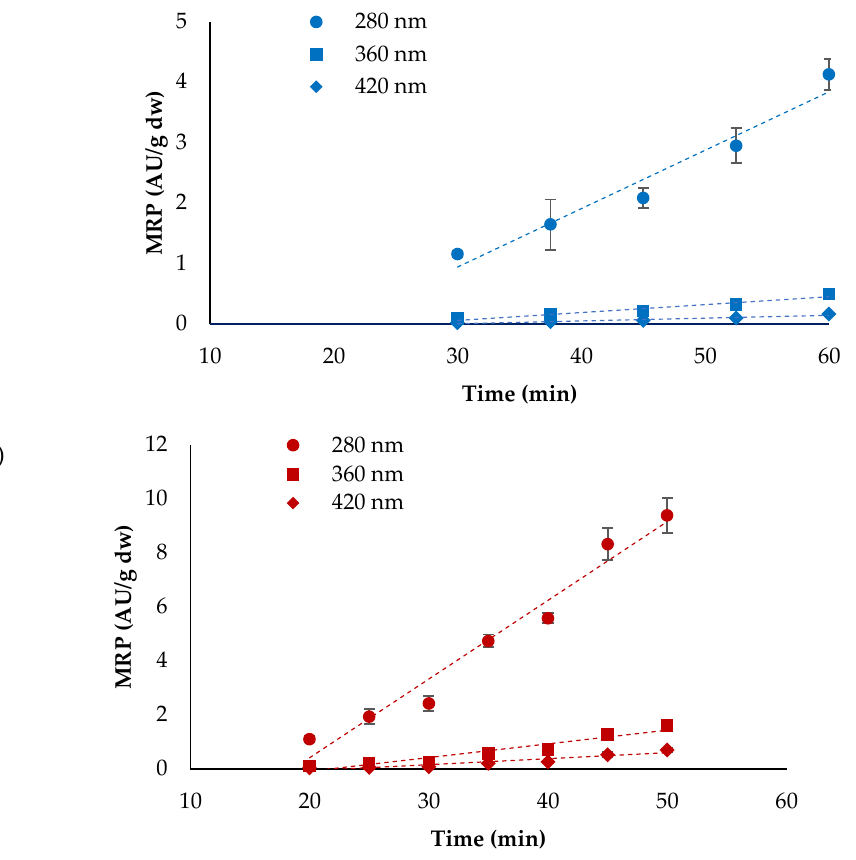
Figure 4. Evolution of Maillard reaction products (MRP) determined at 280, 360 and 420 nm in bread baked at 200 ◦ C ( a ) and 225 ◦ C ( b ). Average of replicate trials, bars represent standard deviation. MRP evaluated at 280, 360 and 420 nm were positively correlated with the BI (linear correlation, r = 0.951, r = 0.819, r = 0.856, respectively; p < 0.0001), and with the IM (linear correlation, r = − 0.951, r = − 0.824, r = − 0.862, respectively; P < 0.0001) confirming